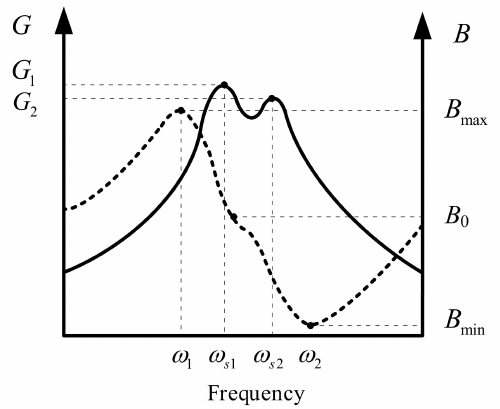
Figure 2. Conductance G (in solid line) and susceptance B (in dotted line) of transducer with closely spaced adjacent